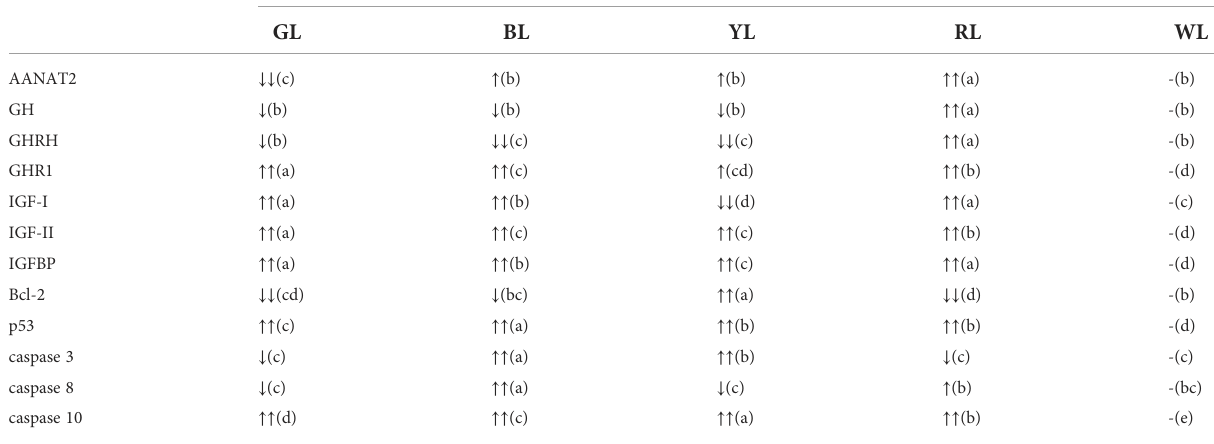
TABLE 3 mRNA level of genes associated with GH/IGF-I axis and apoptosis in juvenile Takifugu rubripes exposed to different light spectra in comparison with WL.